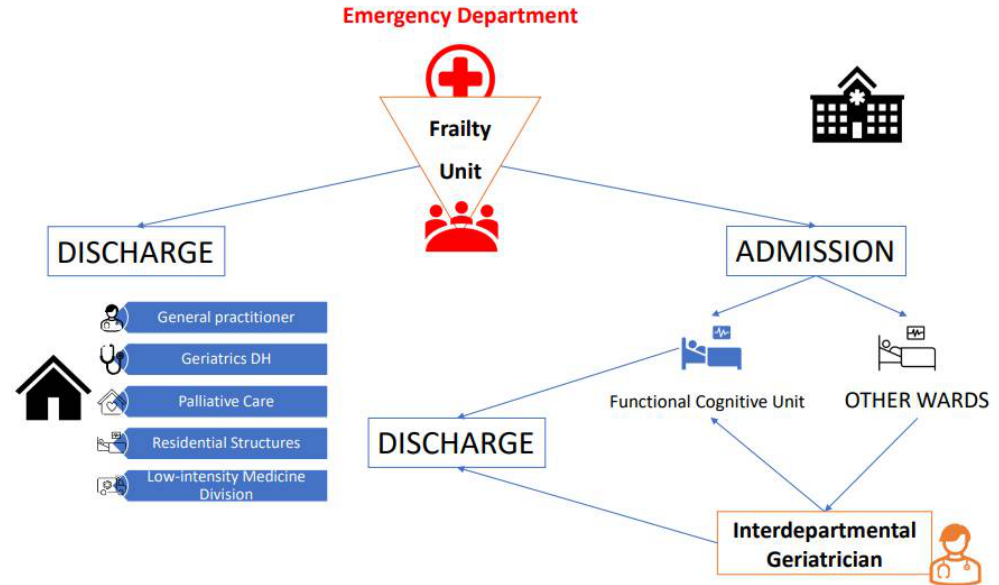
Figure 4. The Geriatric Frailty Network: the discharge flow chart.